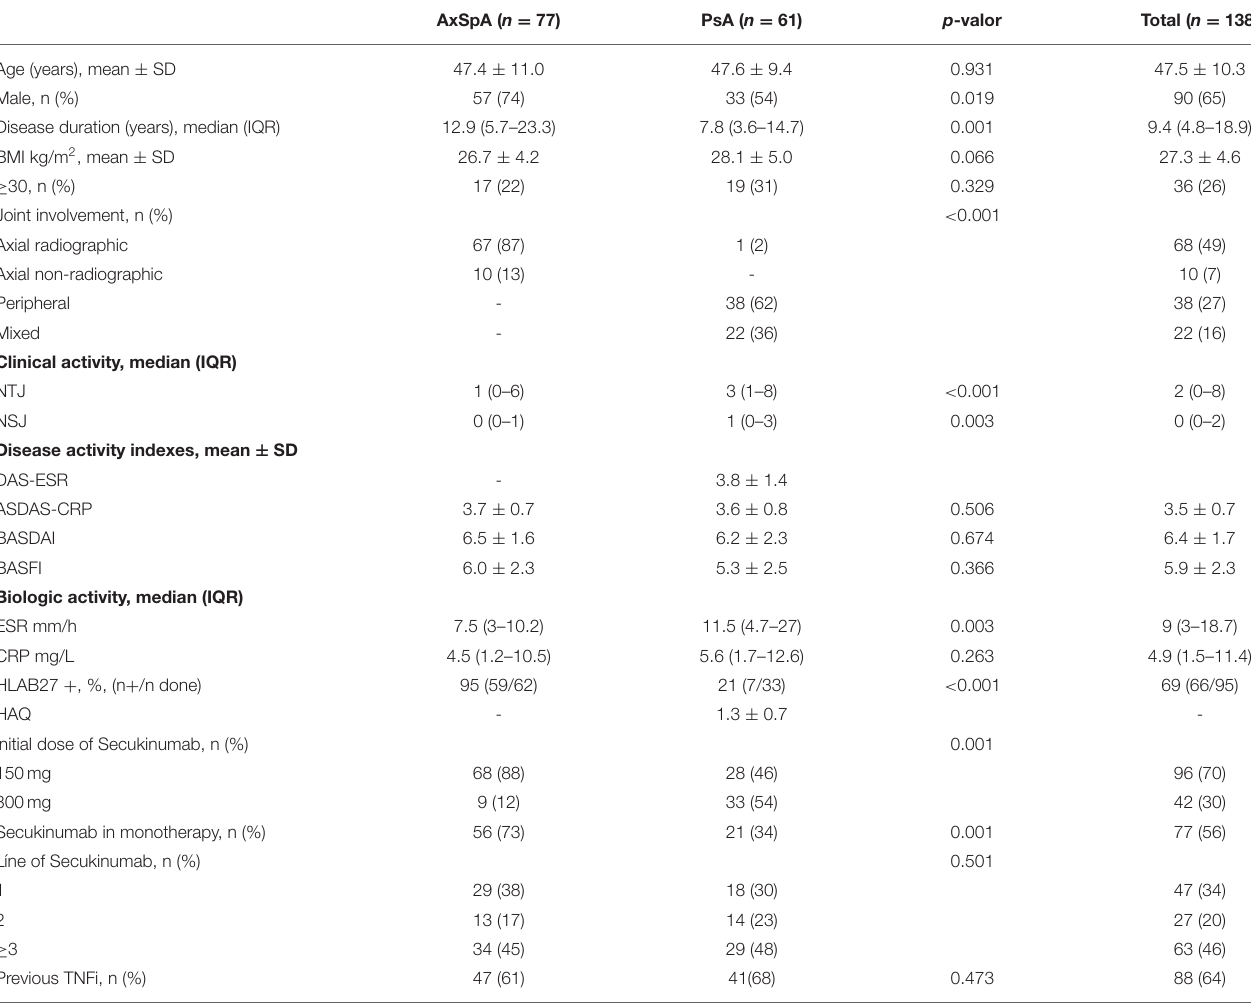
TABLE 1 | Baseline demographic and clinical characteristics; secukinumab use in the study